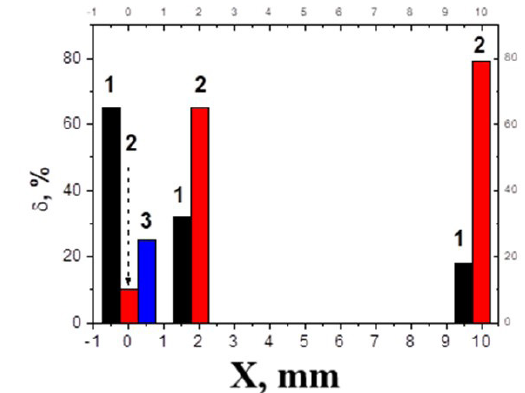
Figure 6. Diagram of relative content of rail structural constituents; 1 - degenerate pearlite + fractured pearlite; 2 - lamellar pearlite; 3 - ferrite-carbide mixture.